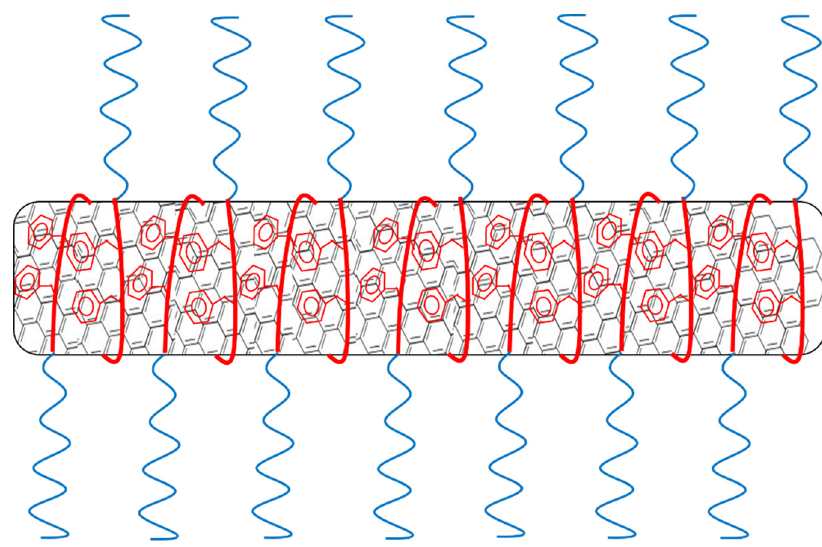
Figure 5. Schematic visualization of micelle encapsulation of nanotubes by the amphiphilic polymer.